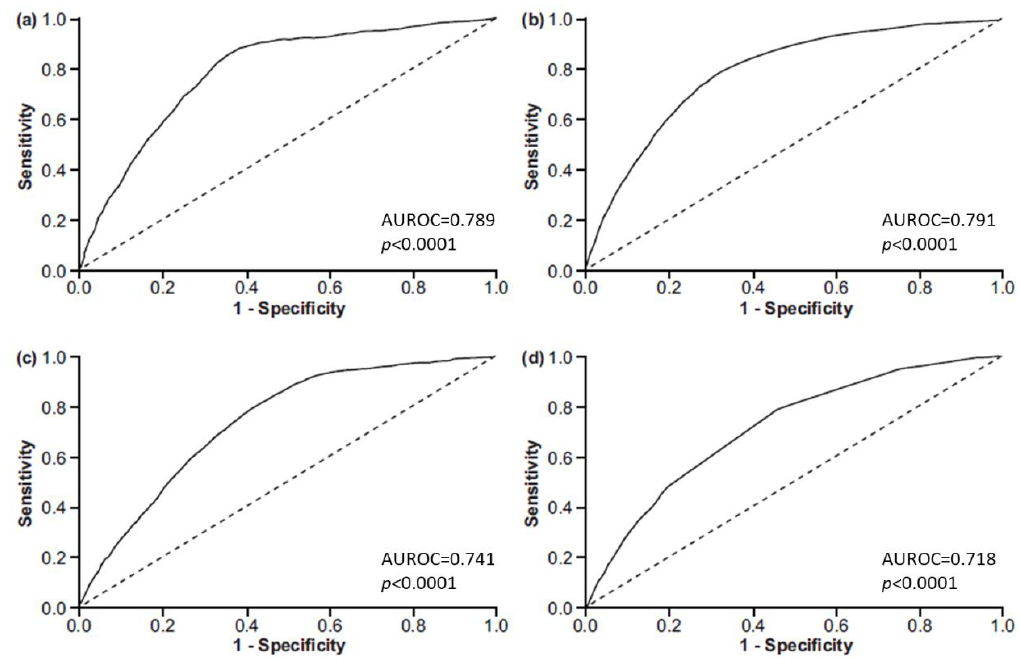
Figure 3. AUROC curves showing the questionnaires′ ability to predict hypomagnesemia in women with hormone-related conditions for: ( a ) MDQ-62 using the cut-off <0.8 mmol/L; ( b ) MDQ-62 using the cut-off <0.66 mmol/L; ( c ) MDQ-23using the cut-off <0.8 mmol/L; ( d ) MDQ-10 using the cut-off <0.66 mmol/L. AUROC, area under the receiver operating characteristic; MDQ, magnesium deficiency questionnaire; The presented p values are related to ROC curves implying the H0 hypothesis: AUC = 0.5.